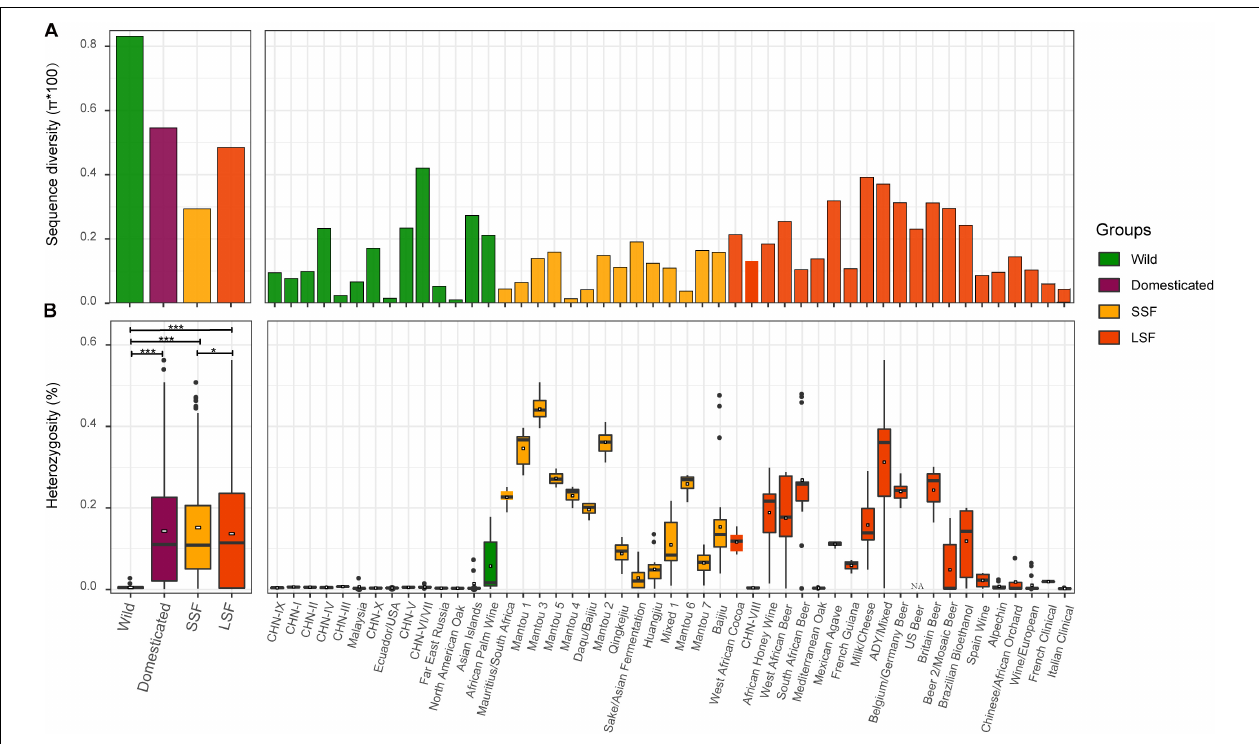
FIGURE 2 | Sequence diversity (A) and heterozygosity (B) of different populations, groups and lineages of S. cerevisiae . Sequence diversity (A) is calculated from genome-wide SNPs, and heterozygosity (B) is expressed as the ratio of heterozygous SNPs to the consensus genome size of each isolate. LSF, liquid-state fermentation; SSF, solid-state fermentation. *, P < 0.05; ***, P <